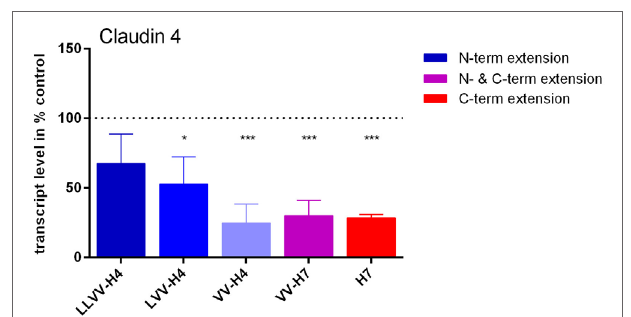
FigUre 8 | Effect of the five hemorphins on claudin-4 mRNA levels in the Caco-2 cells intestinal barrier (IB) model. Caco-2 cells were seeded on the filter of cell culture insert and cultured for 3 weeks until full differentiation as in the IB model. They were then incubated with 100 µM of each hemorphin/ opioid peptide in culture medium for 24 h. Total RNAs were isolated and processed for quantitative real-time PCR analyses. Claudin-4 transcript levels were normalized by reference gene peptidylprolyl isomerase transcript levels and expressed as % of control levels (without opioid peptides). Experiments were run in triplicate and data represented are mean ± SD. *Statistically different from control; * p < 0.05, *** p <